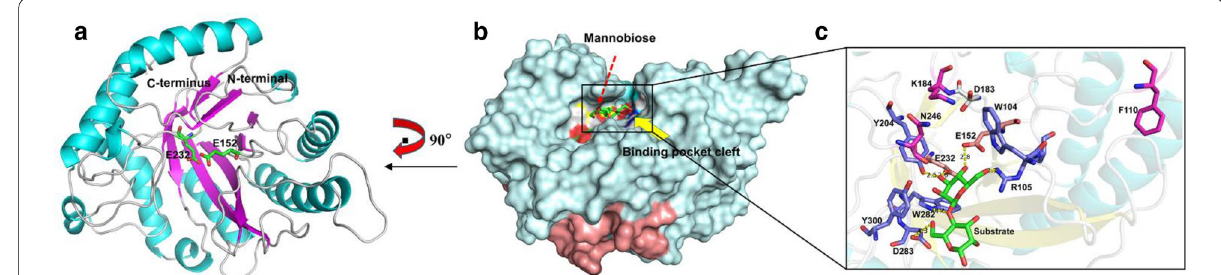
Fig. 4 Structural homology analysis of the PcMan113–substrate complex. a Cartoon representation of the overall structure of PcMan113. Helices are marked by color cyan, β‑sheets in magenta, and loops in white. b Surface representation of the overall structure of PcMan113–mannobiose complex. c Enlarged insight of the catalytically substrate‑binding pocket sites. The two catalytic residues are marked as orange sticks. The two residues are shown in cyan sticks. The substrate mannobiose in b and c is shown as green stick, respectively. Other proposed substrate‑binding sites are showed light blue sticks (W104, R105, Y204, W282, D283 and Y300), magenta sticks (F110, K184 and N246), grey stick (D183),